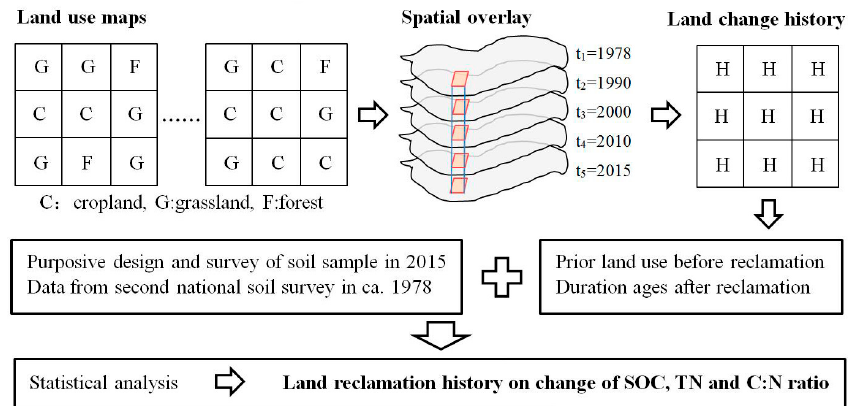
Figure 2. Conceptual framework for exploring impacts of land reclamation history on soil C and N.